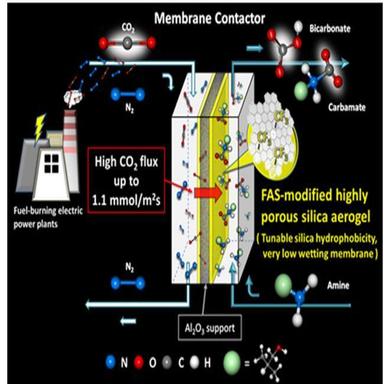
Scheme for CO2 gas absorption in a hydrophobic membrane contactor using fluoroalkyl silane (FAS)-modified mesoporous silica aerogel membranes. Reprinted with permission from Ref. .